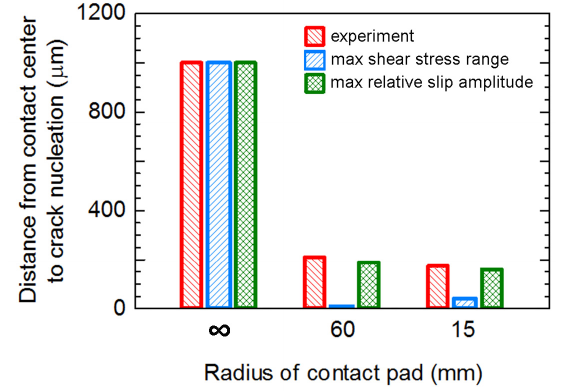
Figure 12. Distances from the contact center to the crack nucleation of fretting fatigue experiments at a stress amplitude of 300 MPa.